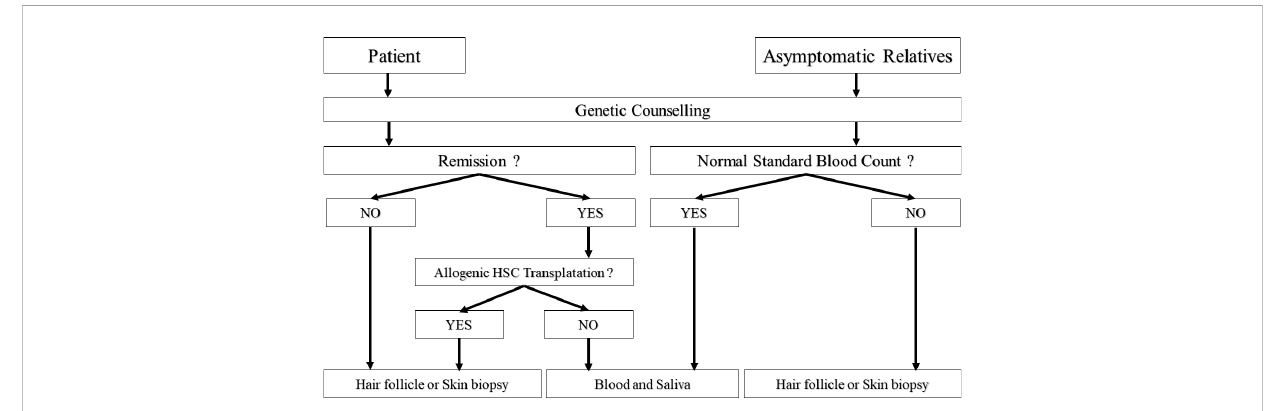
FIGURE 2 Algorithm proposed for diagnostic. HSC = Hematopoietic Stem Cells. Relatives with abnormal standard blood count should be considered as patients. Conversely, patients at remission without HSC transplantation can be analyzed as asymptomatic